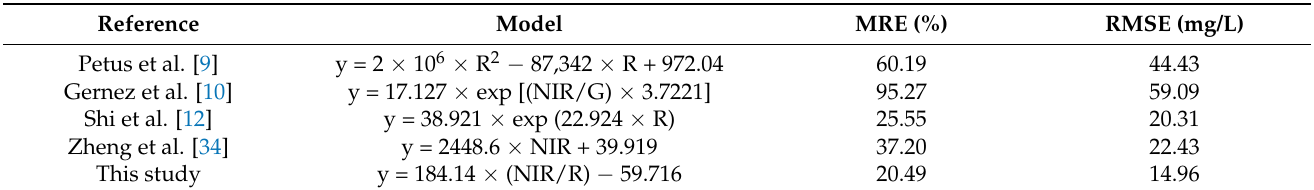
Table 3. Comparison of published TSM concentration inversion models with the model proposed in this study. Reference